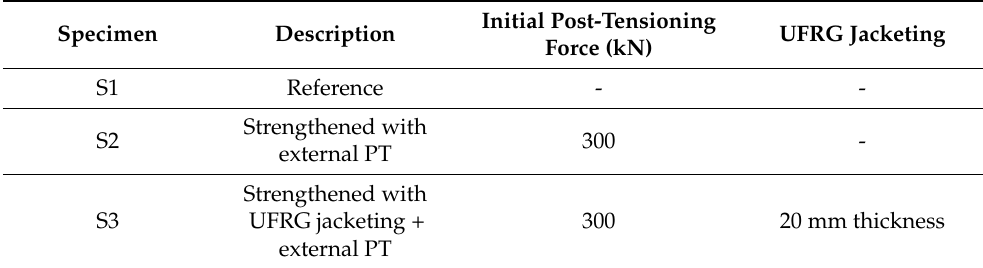
Table 1. Description of the beam